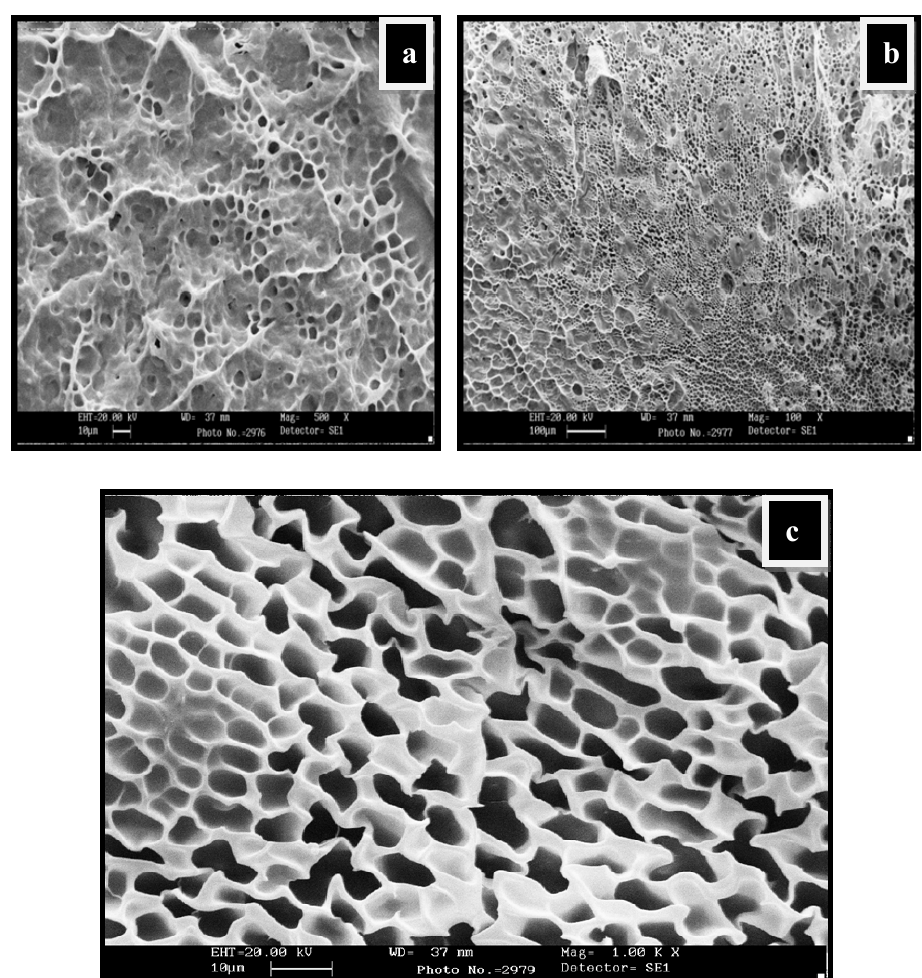
Figure 5. SEM micrographs showing water-swollen NC-2 hydrogel network: ( a ) Swollen structure at magnification 500K×; ( b ) swollen structure at magnification 100×; ( c ) swollen structure showing the interpenetrating network at magnification 1.00K×.